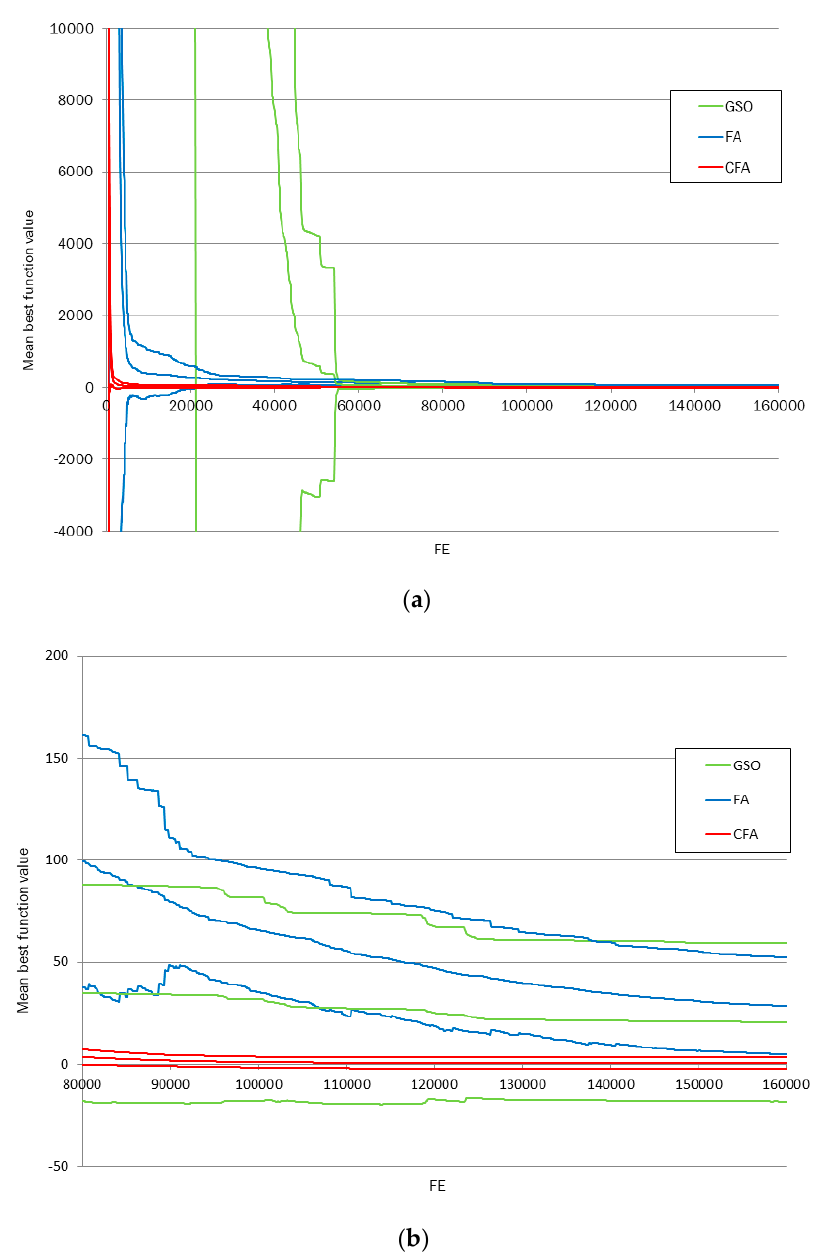
Figure 5. Online performance analysis with 95% confidence interval for the Rosenbrock (30) function. ( a ) The convergence of the best function value during the whole duration of the execution. ( b ) The convergence of the best function value during the second half duration of the execution.